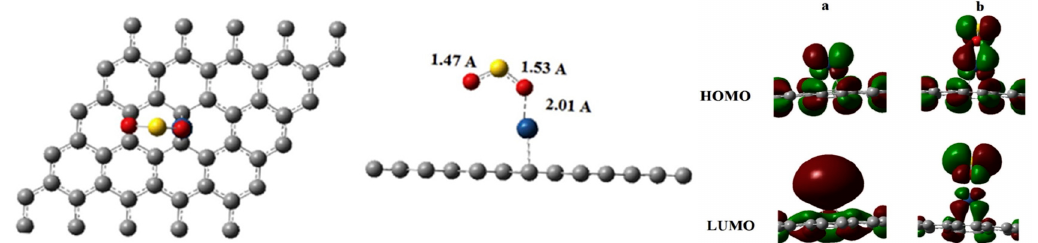
Figure 3. Adsorption configuration and orbital distributions for SO 2 adsorbed on Pt-graphene. ( a ) isolated Pt-graphene; ( b ) Pt-graphene/SO 2 . Reproduced with permission from [56]. Copyright 2016 Vacuum.